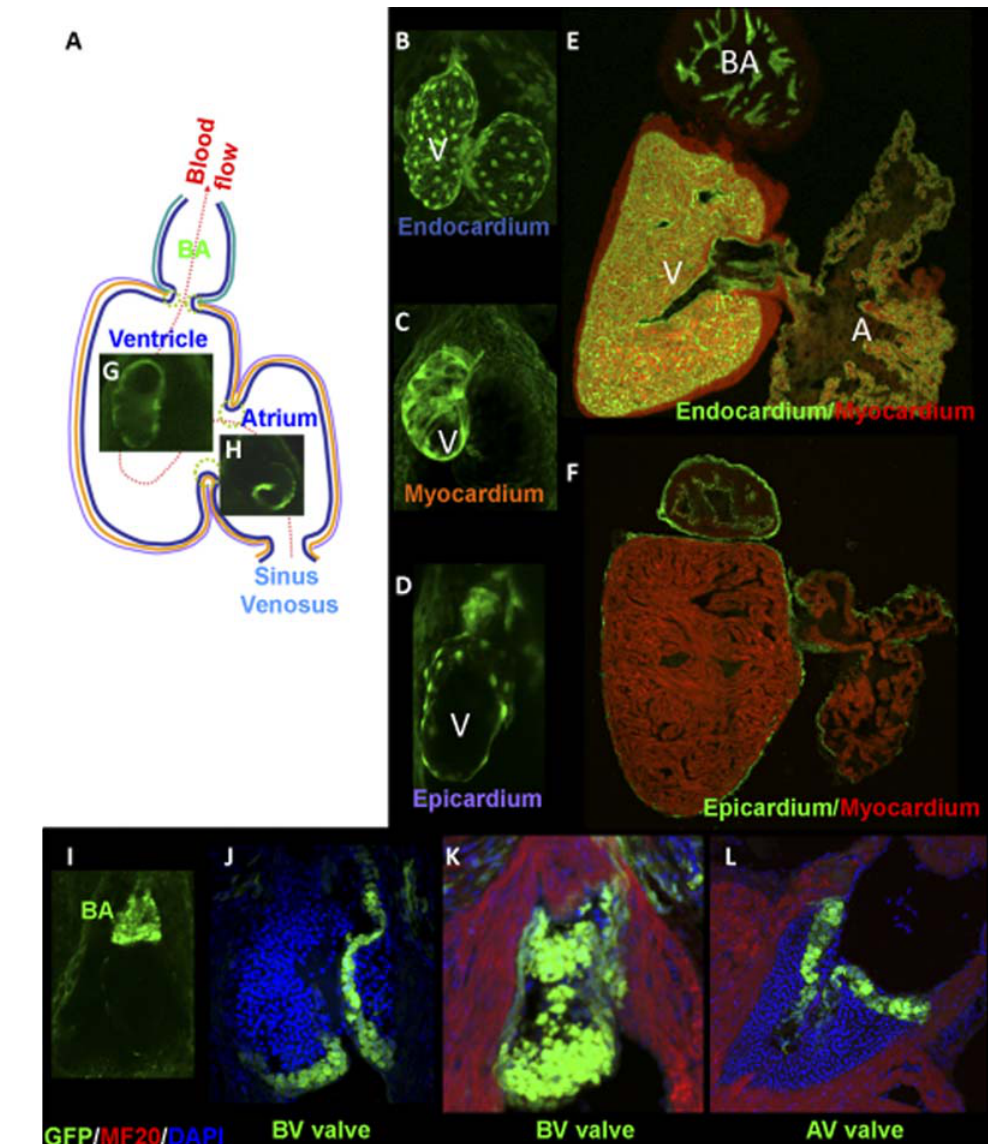
Figure 2. Transgenic labeling of tissues and cell types in the zebrafish heart using GFP reporter genes. (A) The different cell types of the zebrafish heart are GFP-labeled by transposon mediated insertional transgenesis. (A) Schematic depiction of a zebrafish heart indicating the route of blood flow from the sinus venous, through the atrium, ventricle and exiting from the bulbus arteriosus . GFP expression present in the three cardiac layers - (B,E) endocardium, (C) myocardium and (D, F) epicardium as well as examples of transgenes with a region-specific expression pattern including the (G) ventricle, (H) atrium, (I) bulbus arteriosus and (J-L) valves. Expression patterns are shown in the (B-D, I) embryonic, or (E-F,J-L) adult heart. Abbreviations: A, atrium; AV, atrioventricular valve; BA, bulbus arteriosus ; BV, bulboventricular valve; V, ventricle. From 11 with